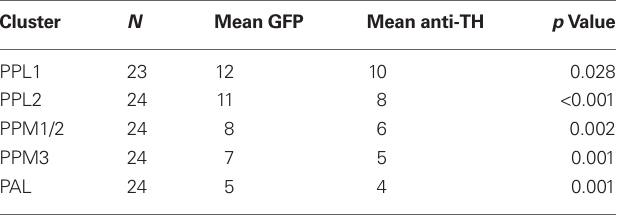
Table 1 | Numbers of TH > mCD8::GFP and anti-TH labeled DA neurons in the adult Drosophila brain.